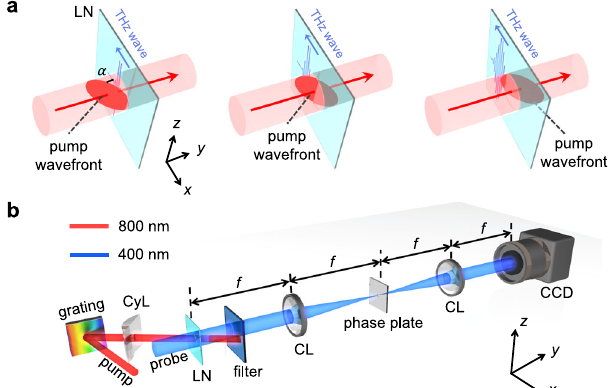
pump pulse and generated THz wave. a Velocity matching of the tilted- wavefront pump laser and the generated THz wave. The red ellipsoids indicate the wavefront of the pump pulse. The red arrows indicate the propagation direction of the pump pulse. b Experimental setup and detection of THz waves based on a pump-probe technique. CyL: cylindrical lens; LN: lithium niobate sample; CL: convex